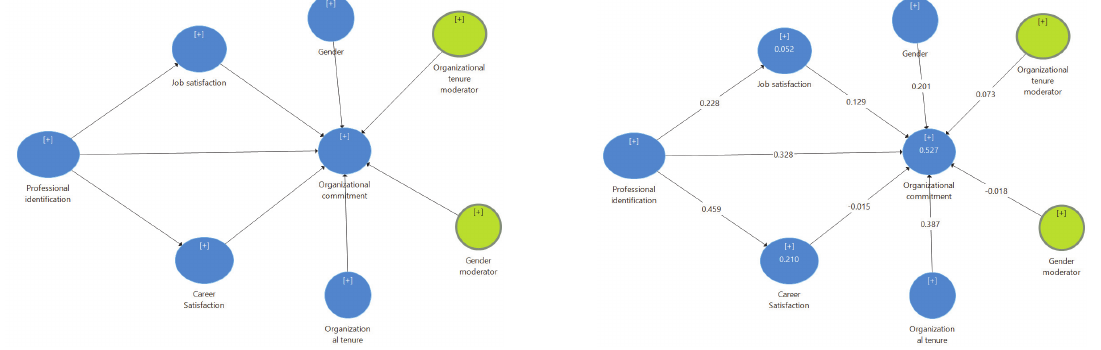
Fig. 10. Model of regulatory role research Fig. 11. Impact coefficient results of the latent variables in the model with moderator variables